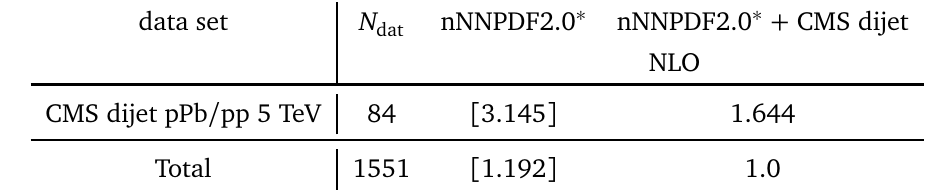
Table 3: Comparison between the χ 2 per data point of nNNPDF2.0 ∗ and a new NLO determination including the pPb / pp CMS 5 TeV spectra. Values enclosed in square brackets are of the data set that is not included in the fit.